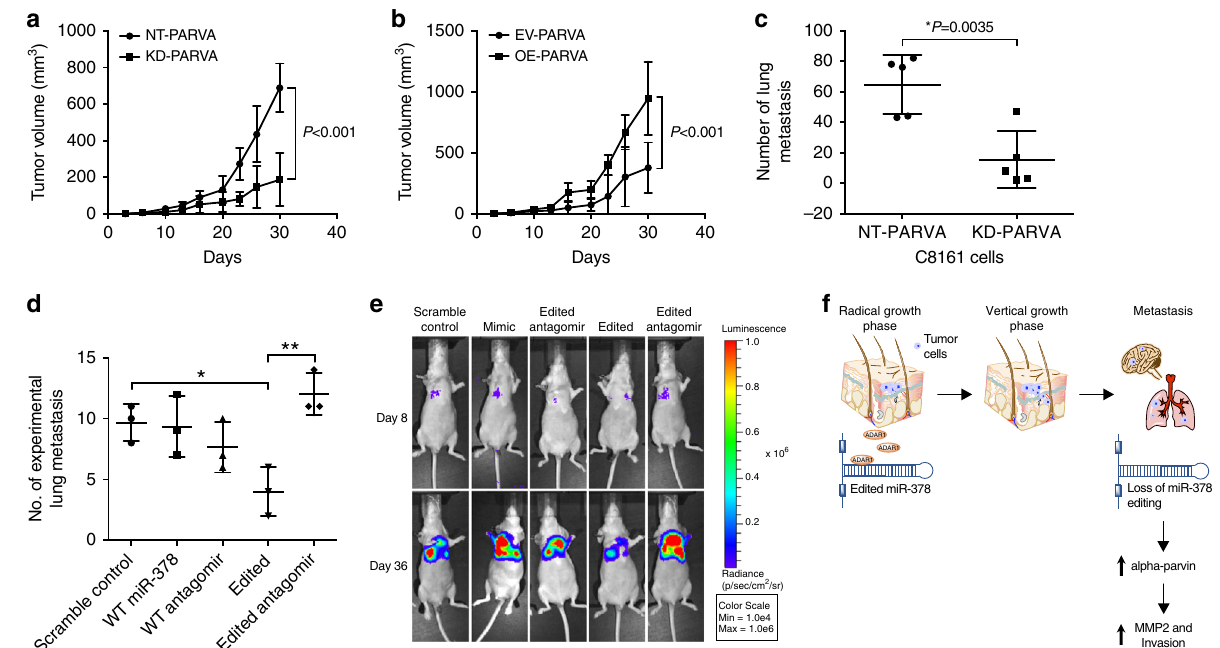
Fig. 4 Contribution of PARVA and miR-378a-3p to melanoma tumor growth and metastasis in vivo. a , b Effect of manipulation of PARVA on subcutaneous tumor growth. a Knockdown (KD) of PARVA in C8161 cells (1 × 10 6 ) resulted with a signi fi cant reduction in tumor growth compared with the non-targeting (NT) control, P < 0.001. For each group, n = 5 mice, statistical signi fi cance by two-tailed Student t test, error bars represent s.d. b Overexpression (OE) of PARVA in SB2 cells (1 × 10 6 ) signi fi cantly increased tumor growth compared to the empty vector (EV) control, P < 0.001. For each group n = 5 mice, statistical signi fi cance by two-tailed Student t test, error bars represent s.d. c Silencing of PARVA in C8161 cells signi fi cantly reduced the number of experimental lung metastases, P = 0.0035. Statistical signi fi cance by two-tailed Student t test; error bars represent s.d. d , e C8161 luciferase labelled cells (2 × 10 5 ) were injected intravenously, and 3 days later the mice were treated via intra-peritoneum injection with either scramble control, miR-378a-3p wild- type (WT), WT antago-miR, edited miR-378, or edited antago-miR encapsulated in 1, 2-dioleoyl-sn-glycero-3-phosphocoline (DOPC) particles. The data shown represent 36 days after injections. d Delivery of edited miR-378a-3p to mice harboring C8161 cells (2 × 10 5 ) decreased their metastatic potential when compared to scramble control ( P ≤ 0.05) and when compared to its antago-miR ( P ≤ 0.01). Statistical signi fi cance by Tukey ’ s multiple comparisons test. For each group n = 3. e Representative luciferase imaging at 36 days after cells injection. f Model of miR-378a-3p editing in melanoma progression. ADAR1 is lost in the transition from radial growth phase to vertical growth phase, consequently there is an accumulation of WT miR-378a-3p in metastatic melanoma causing overexpression of PARVA and MMP-2 thus contributing to melanoma invasion and lentivirus for overexpression or knockdown of the genes of interest. These cells were grown in DMEM supplemented with 10% FBS. Primary normal human melanocytes cells were obtained from Promo Cell (Cat. # C-12403). The following human melanoma cells were used: SB2 cells poorly metastatic that was originated